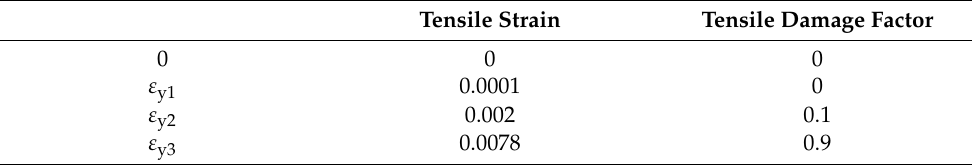
Table 2. Relation between tensile strain and tensile damage factor.